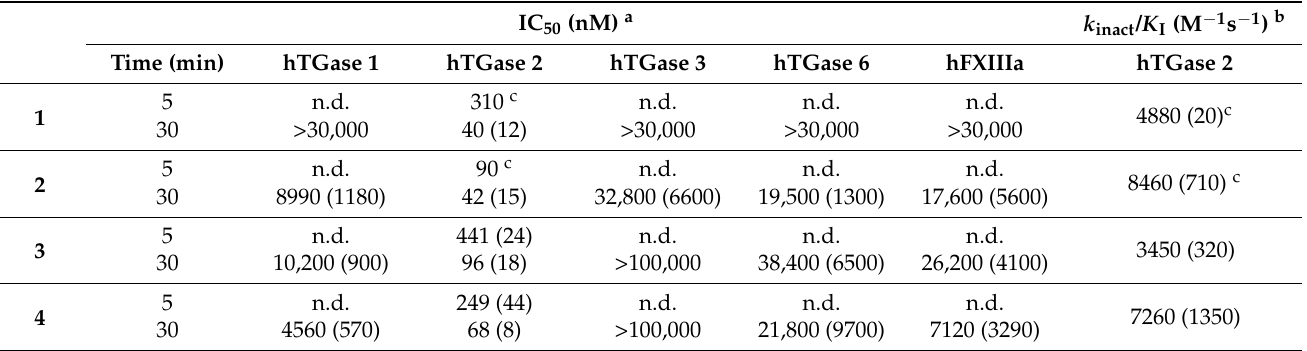
Table 2. Summary of inhibition parameters of compounds 1–4 toward different human